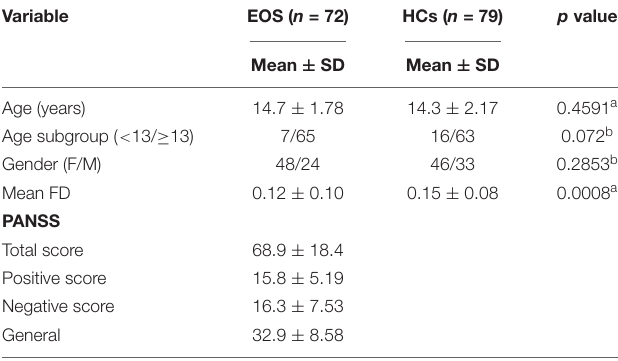
TABLE 1 | Demographic and clinical characteristics of the